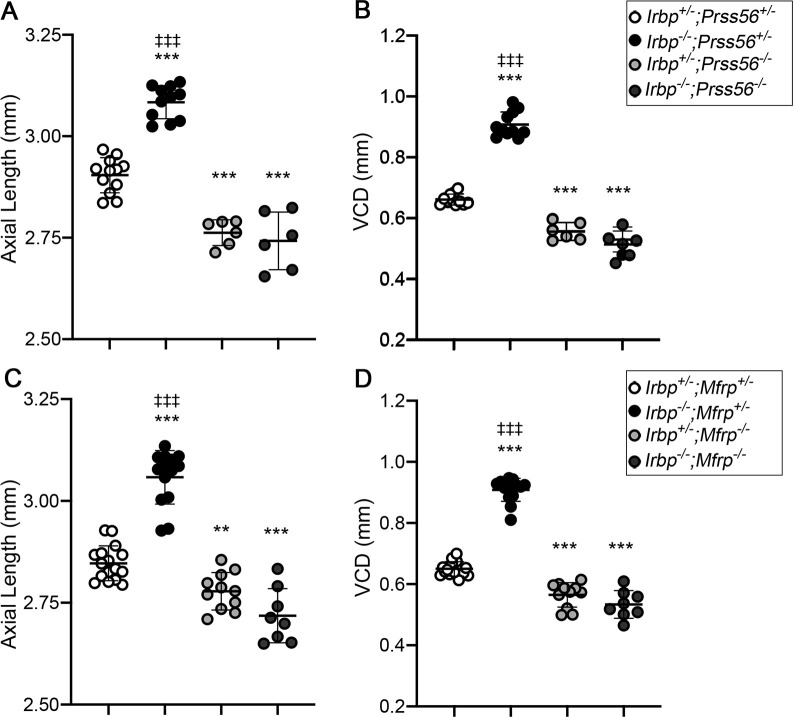
Excessive ocular axial elongation in Irbp mutant mice is dependent on PRSS56 and MFRP.(A-D) Scatter plot showing quantification of ocular axial length (A and C) and VCD (B and D) in Irbp mutant mice carrying heterozygous or homozygous mutations in Prss56 or Mfrp. Biometric analyses revealed that ocular axial length (A and C) and VCD (B and D) were significantly increased in Irbp mutant mice (Irbp-/-;Prss56+/- in A and B, and Irbp-/-;Mfrp+/- in C and D) and significantly reduced in Prss56 and Mfrp single mutant mice (Irbp+/-;Prss56-/- in A and C and Irbp+/-; Mfrp-/- in B and D, respectively) compared to their respective control littermates (Irbp+/-;Prss56+/- or Irbp+/-;Mfrp+/-). Notably, Prss56 and Mfrp inactivation prevented ocular axial elongation in Irbp mutant mice, as ocular axial length and VCD of Irbp-/-;Prss56-/- and Irbp-/-; Mfrp-/- are comparable to those of Prss56 or Mfrp single mutants (Irbp+/-;Prss56-/- and Irbp+/-; Mfrp-/-, respectively). Data are presented as mean ± SD (A-D), N≥6 eyes/group. **p<0.01; ***p<0.001 (for comparison to control Irbp+/-;Prss56+/- or Irbp+/-;Mfrp+/- mice); ‡‡‡p<0.001 (for comparison to Irbp-/-;Prss56-/- or Irbp-/-; Mfrp-/- mice), one-way ANOVA.